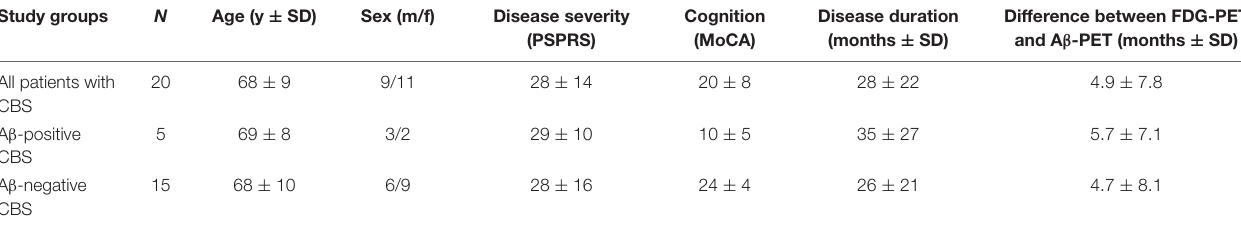
TABLE 1 | Demographics of the study population.